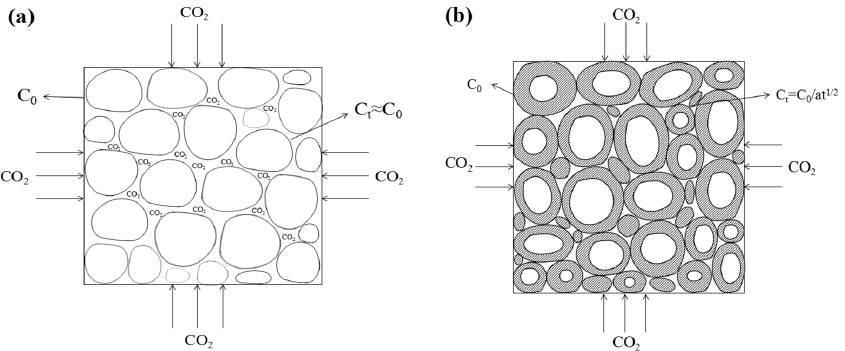
Figure 4. Schematic diagram of CO 2 concentration on the particle surface. (( a ) shows the initial stage of carbonization, ( b ) shows the carbonization process).